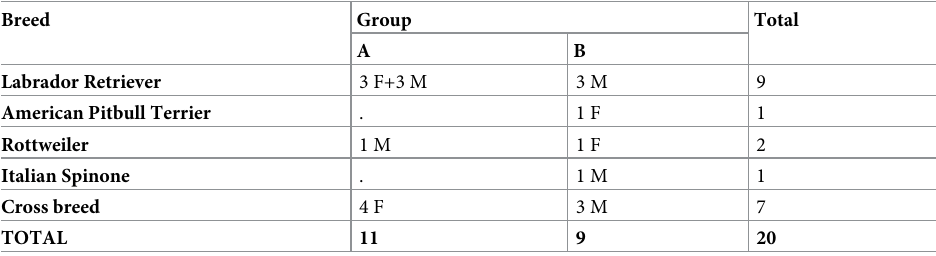
Table 1. Distribution of study population for breed and sex. Breed